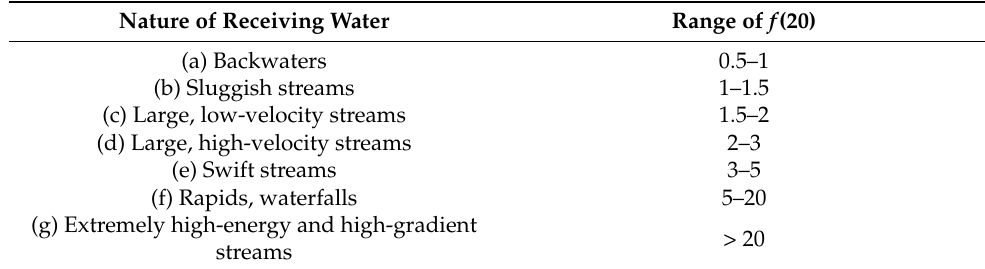
Table 2. Approximate values for the self-purification constant for CBOD at 20 ◦ C as originally suggested by Fair [2] and supplemented by very high-energy streams